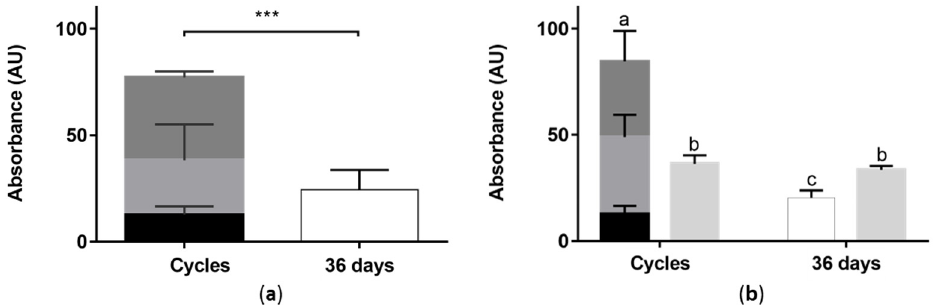
Figure 8. Absolute absorbance obtained for ( a ) free mycelium (SmF) and ( b ) immobilized mycelium on inert support (SmFi) with culture medium change (Cycles), and without culture medium change (36 days). For culture medium change, the absorbance from the first (black), second (gray), and third (dark gray) cycles of 12 days was represented together with the value obtained for 36-days fermentation (white). The ethanolic extract obtained at the end of 36 days (cycles and extended batch) under SmFi is represented by light gray bars. Values are the mean ± SD ( n = 3). Statistical analysis was performed between cycles, and between Cycles and 36 days by one-way ANOVA. ( a ) *** p < 0.001); ( b ) bar graphs which have the same letter are significantly equal therefore p is not bellow 0.05. On contrary, different letters are significantly different from each other ( p < 0.05).